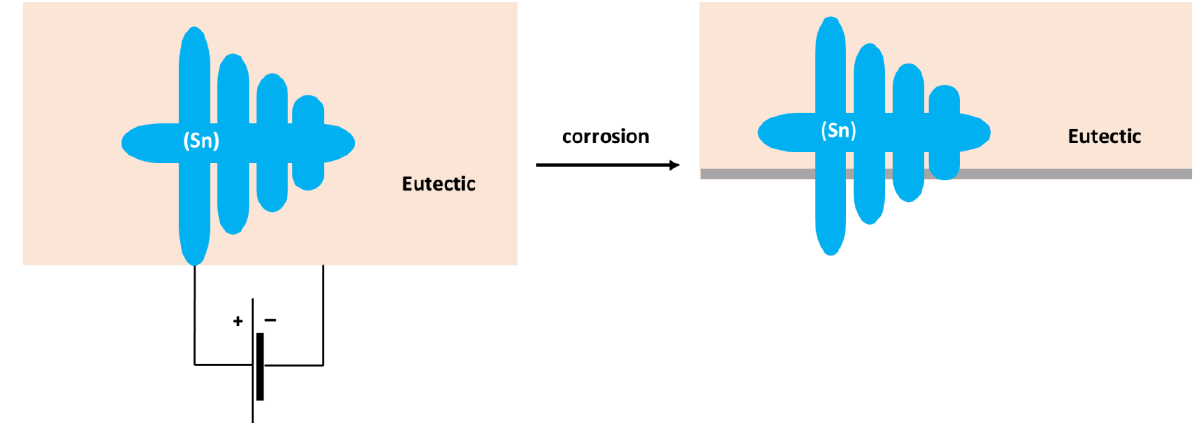
Figure 10. Schematic of microgalvanic cell formation in the Sn – 5Zn alloy.